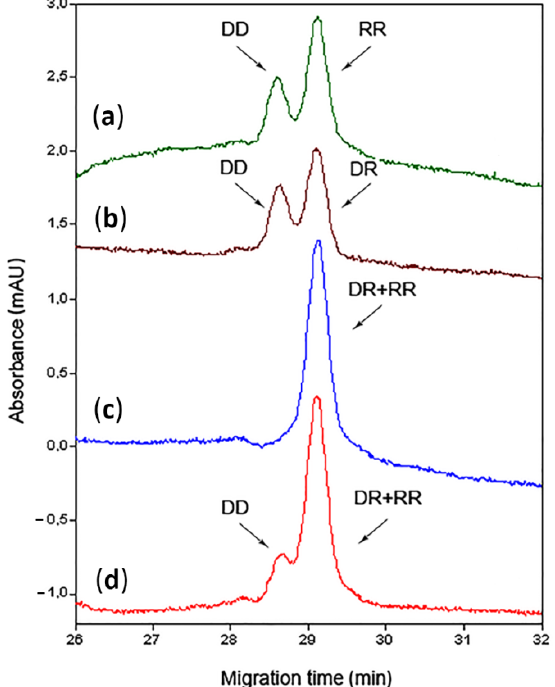
Figure 1. Capillary electrophoresis (CE) electropherograms for 50 µ M peptide mixtures. Ultraviolet (UV) absorbance measured at 200 nm. Buffer: 10 mM ammonium acetate adjusted to pH of 3.45 with acetic acid. ( a ) Mixture of direct-direct (DD) and reverse-reverse (RR) peptides; ( b ) Mixture of DD and direct-reverse (DR) peptides; ( c ) Mixture of DR and RR peptides; ( d ) Mixture of DD, DR, and RR peptides. The peak of electroosmotic flow outcomes at 42 min (not shown).